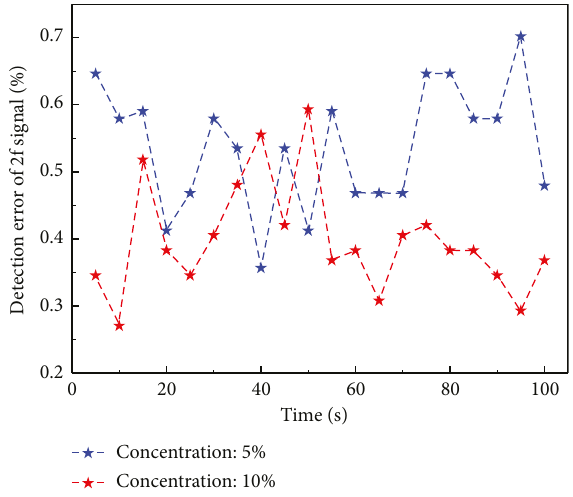
Figure 6: Performance test of the digital lock-in ampli fi er.